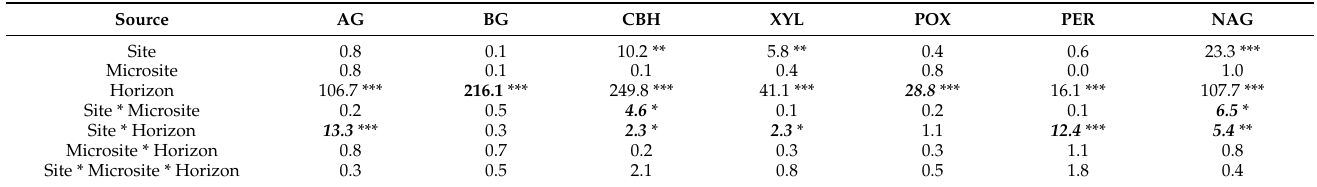
Table 3. Results (F-values and significance) of three-way ANOVA testing effects of site (natural vs. drained wetland), microsite (high vs. low from each site), and soil horizon on extracellular enzyme activity per unit mass of SOC ( µ mol g SOC − 1 h − 1 ) measured in soils from organic and mineral soil horizons. Bold and italicized values represent the highest level significant main effect or interaction, upon which further interpretation was